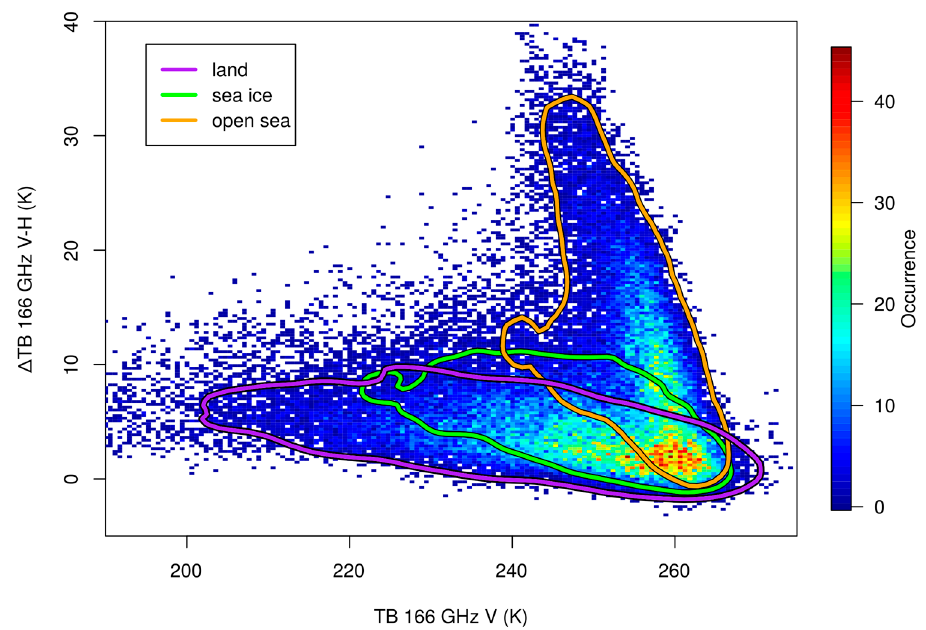
Figure 6. Scatterplot of the 166 GHz ∆ TB-TB 2-D histograms for the whole GMI-CPR snowfall dataset. The 2-D histogram is created by dividing the ∆ TB-TB space in 200 × 100 bins. Each dot represents the mean ∆ TB or TB value in each 2-D bin while the color bar indicates the percentage of occurrences. Contours for 90% occurrences in the three background surface manifolds are also superimposed: open water (orange), land (purple), sea ice (SIC > 57%) (green).